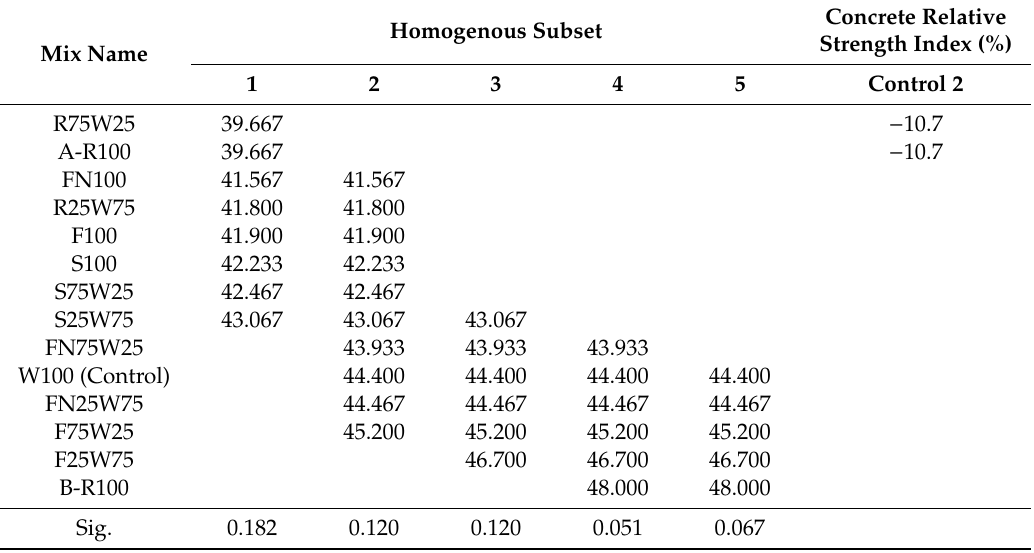
Table 8. Statistical significance of concrete compressive strength at 28 days was evaluated by general liner model multivariate—Tukey homogeneous